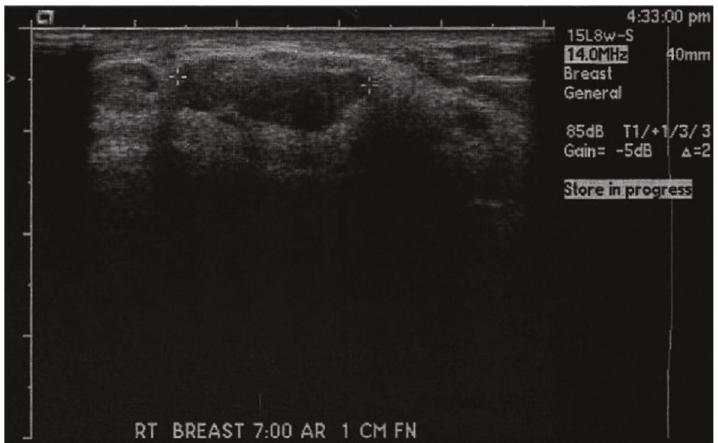
Figure 1: Ultrasound of the right breast before fi ne-needle biopsy shows a nodular density with multiple areas of hyperechoic densities within